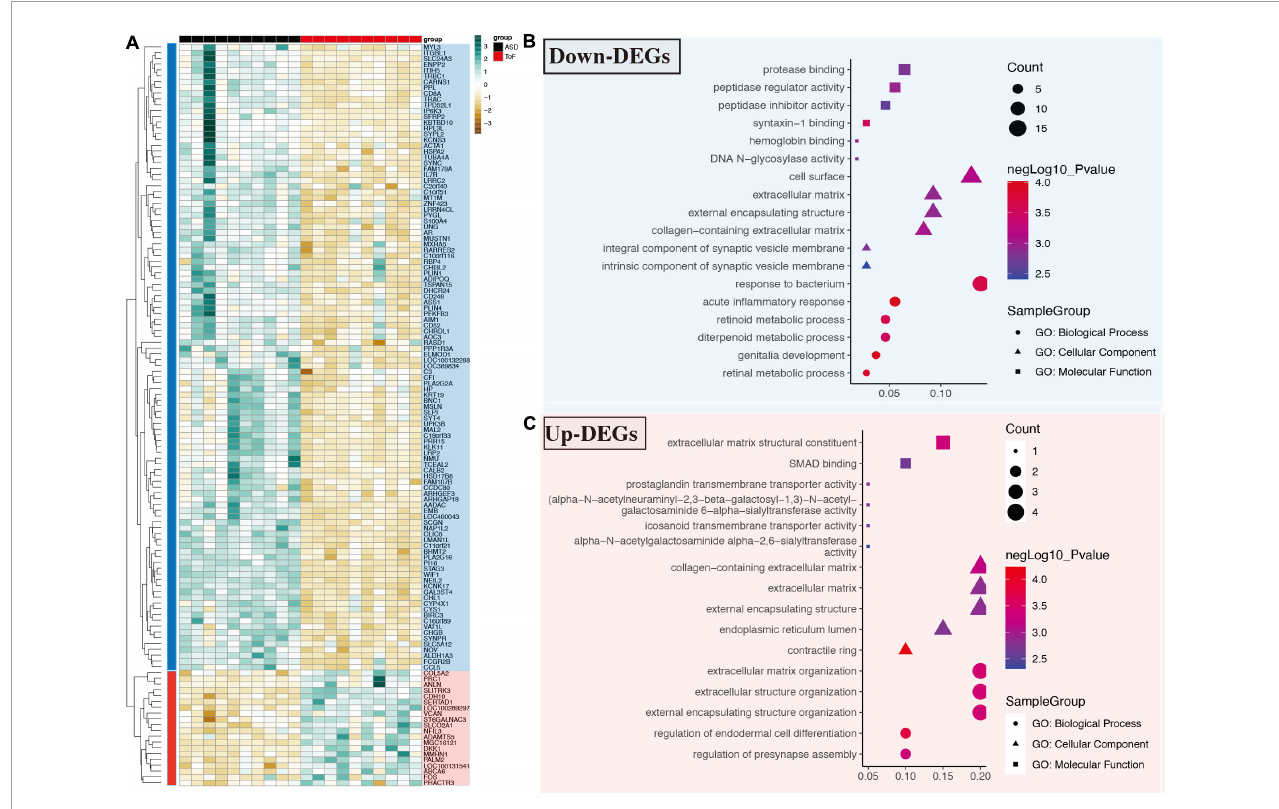
FIGURE1 Differential expressed genes and gene ontology (GO) analysis in GSE132176 dataset. (A) Differentially expressed genes in tetralogy of fallot (TOF) vs. atrial septal defect (ASD). (B) GO analysis of down-regulated genes. (C) GO analysis of up-regulated